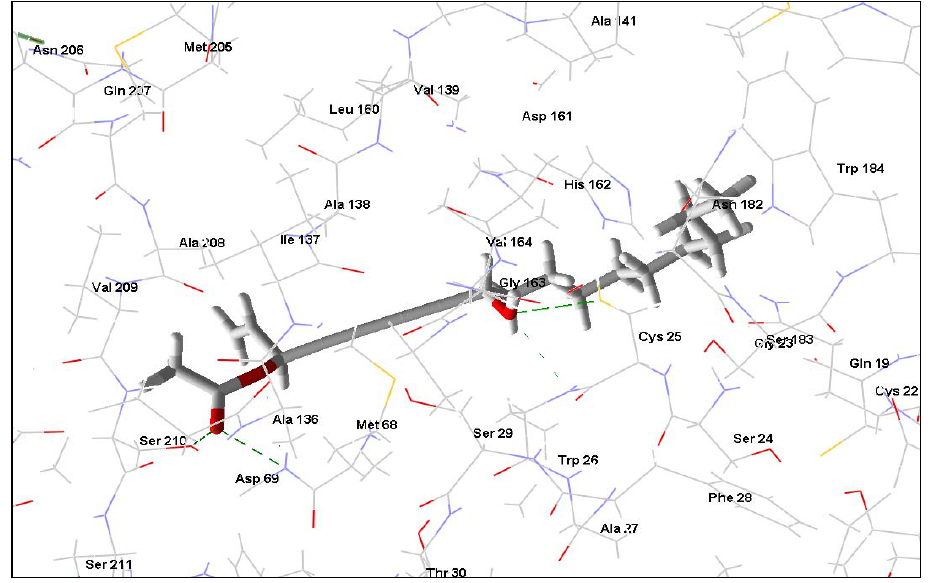
Figure 4. 8-Hydroxylheptadeca-4,6-diyn-3-yl acetate interacting with rhodesain’s active site residues. Hydrogen bonding interactions are shown as green dashed lines.